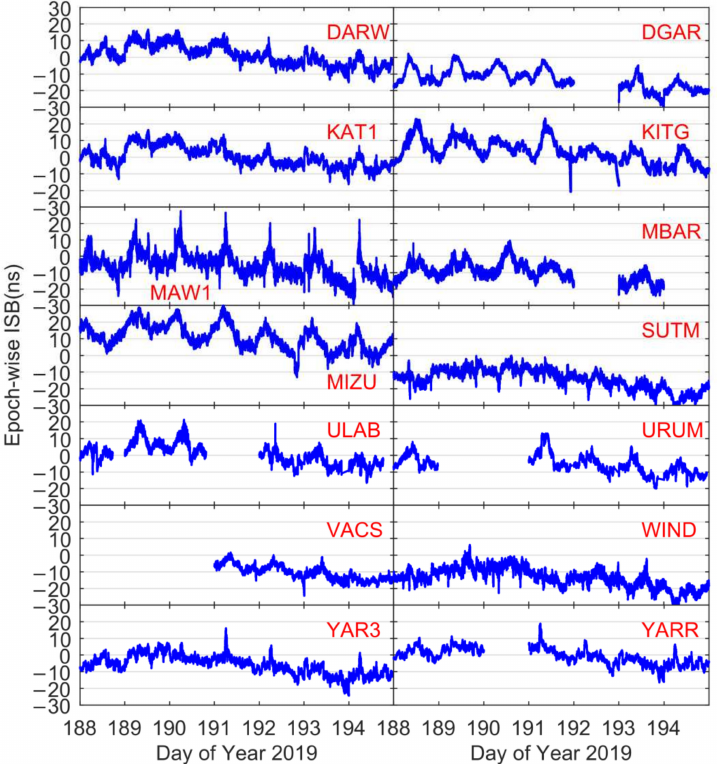
Figure 13. Time series of epoch-wise ISB estimates derived from GPS/IRNSS integrated SPP at 14 MGEX stations on 7–13 July (DOY 188 to 194), 2019.